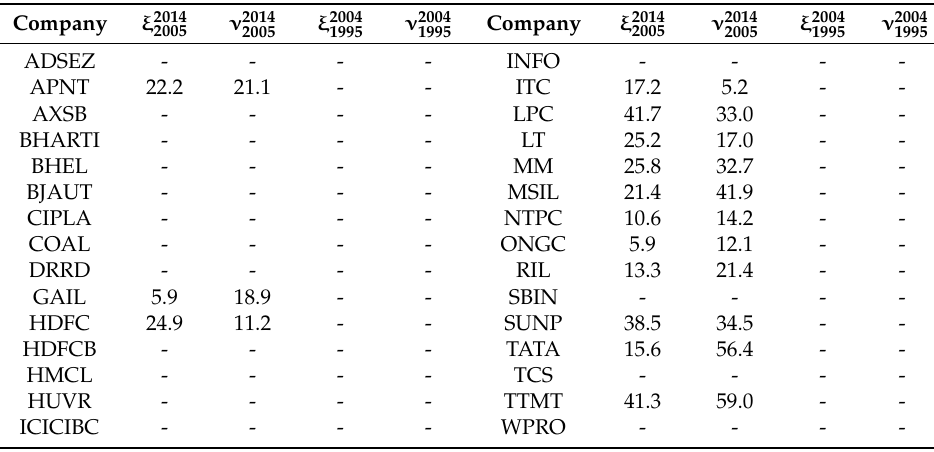
Table A7. Estimated parameters ξ ( % ) and ν ( % ) , for each company of SENSEX index. Company